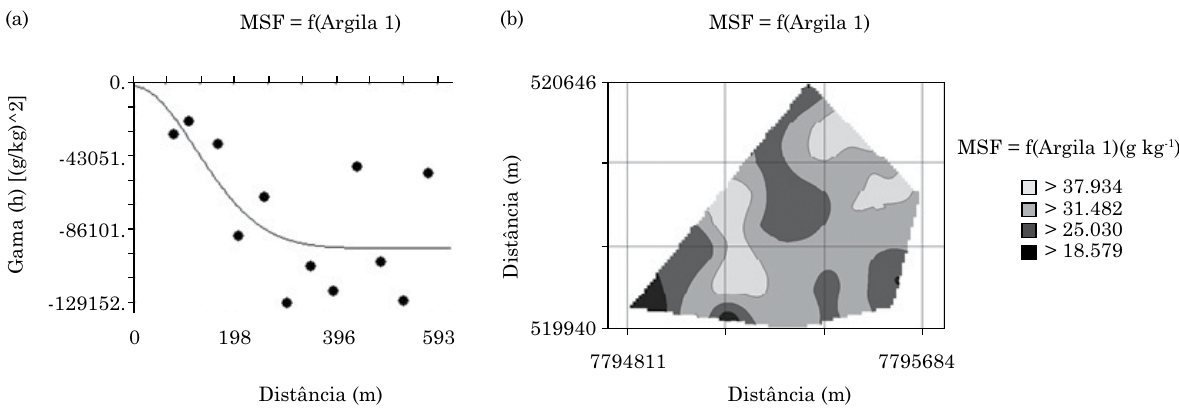
Figura 2. Semivariograma cruzado e mapa de cokrigagem da produtividade de matéria seca de forragem (MSF) de sorgo em função do teor de argila na primeira camada (1 = 0,00-0,10 m) de um Planossolo